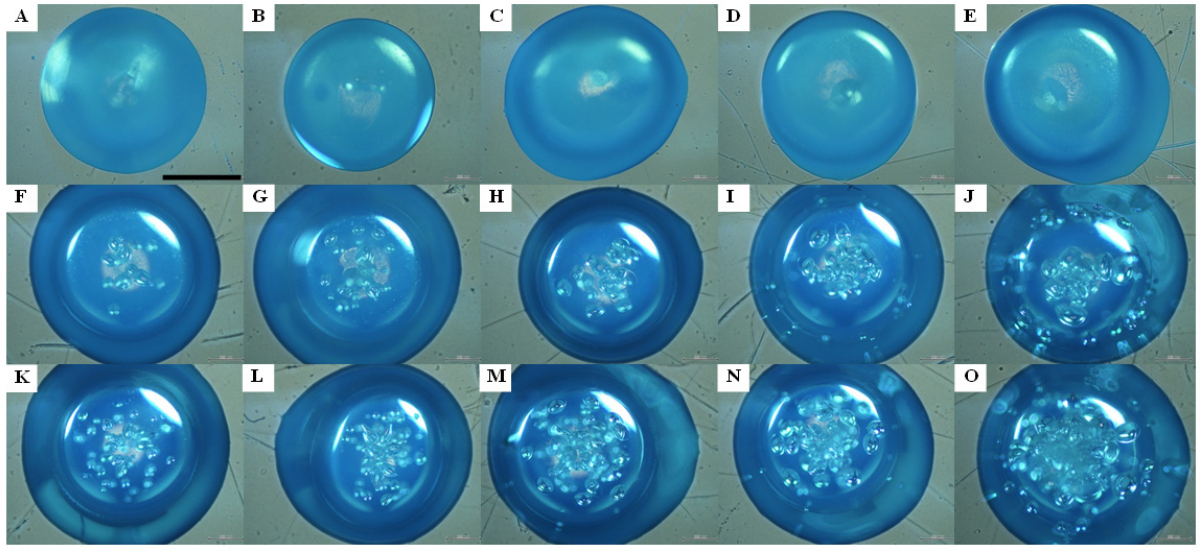
Figure 2. Photo images of the kinetics of gas formation in a single alginate microparticle. is fixed at 1% and the H O concentrations are 0% ( A – E ), The concentration of NaHCO 3 2 2 18.25% ( F – J ), and 36.5% ( K – O ). The gas formation time are 30 seconds ( A , F , K ), 1 minute ( B , G , L ), 3 minutes ( C , H , M ), 5 min ( D , I , N ), and 10 min ( E , J , O ). Scale bar is 1